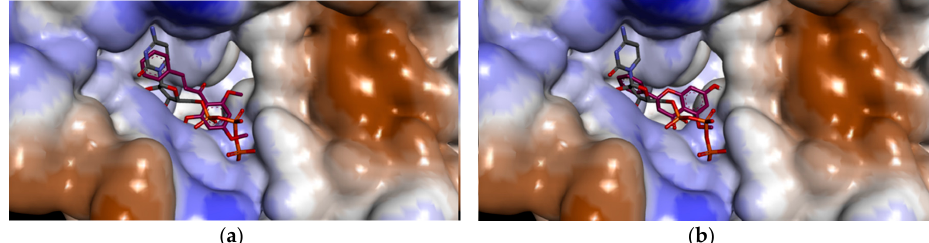
Figure 4. Comparison of the binding mode of UCK2 inhibitors in the ligand binding pocket of UCK2 surface. ( a ) FKB shown in purple color and CTP in maroon color; ( b ) APN shown in purple color and CTP in maroon color.